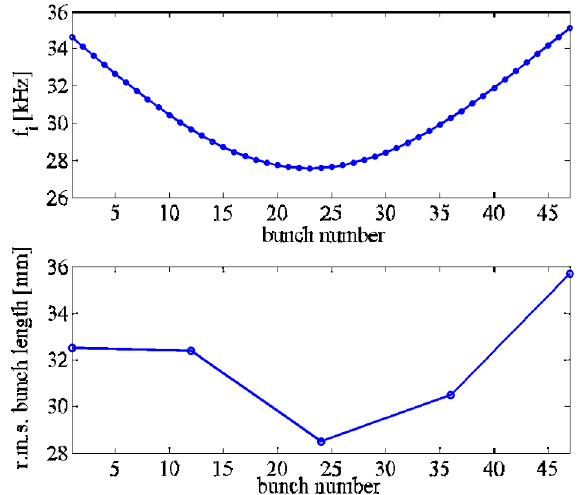
FIG. 11. (Color) rms bunch length and bunch incoherent syn- chrotron frequency along the train.